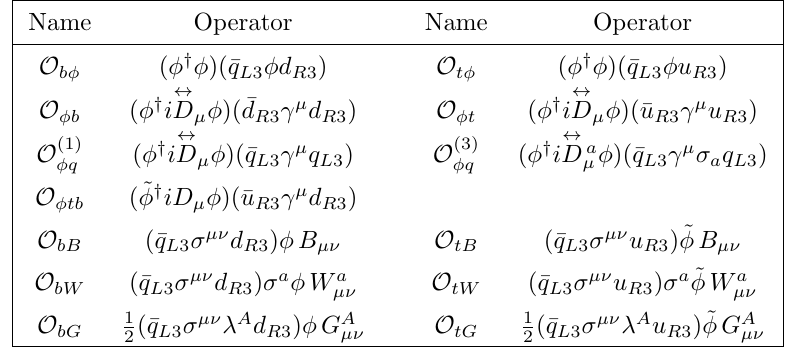
Table 5 . Dimension-6 operators generated by tree-level matching of the e(cid:11)ective theory with each multiplet to the SMEFT. This basis of operators was proposed in [38] and is a subset of the Warsaw basis